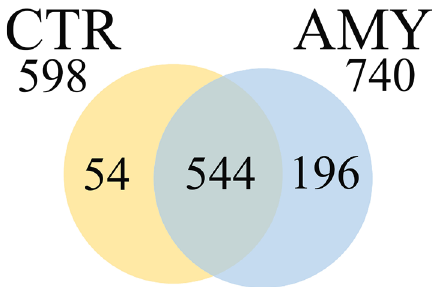
Figure 2. Venn diagram of the proteins identified in FFPE kidney tissues from cats affected by renal amyloidosis (AMY) and healthy (CTR). Only proteins present and quantified in at least 2 out of 3 repeats in each group were considered as positively identified.